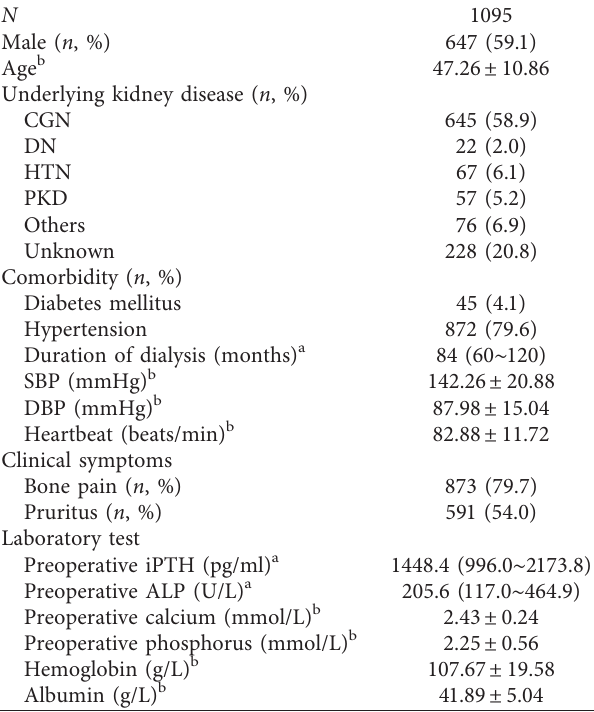
Table 1: The clinical characteristics of the patients who underwent